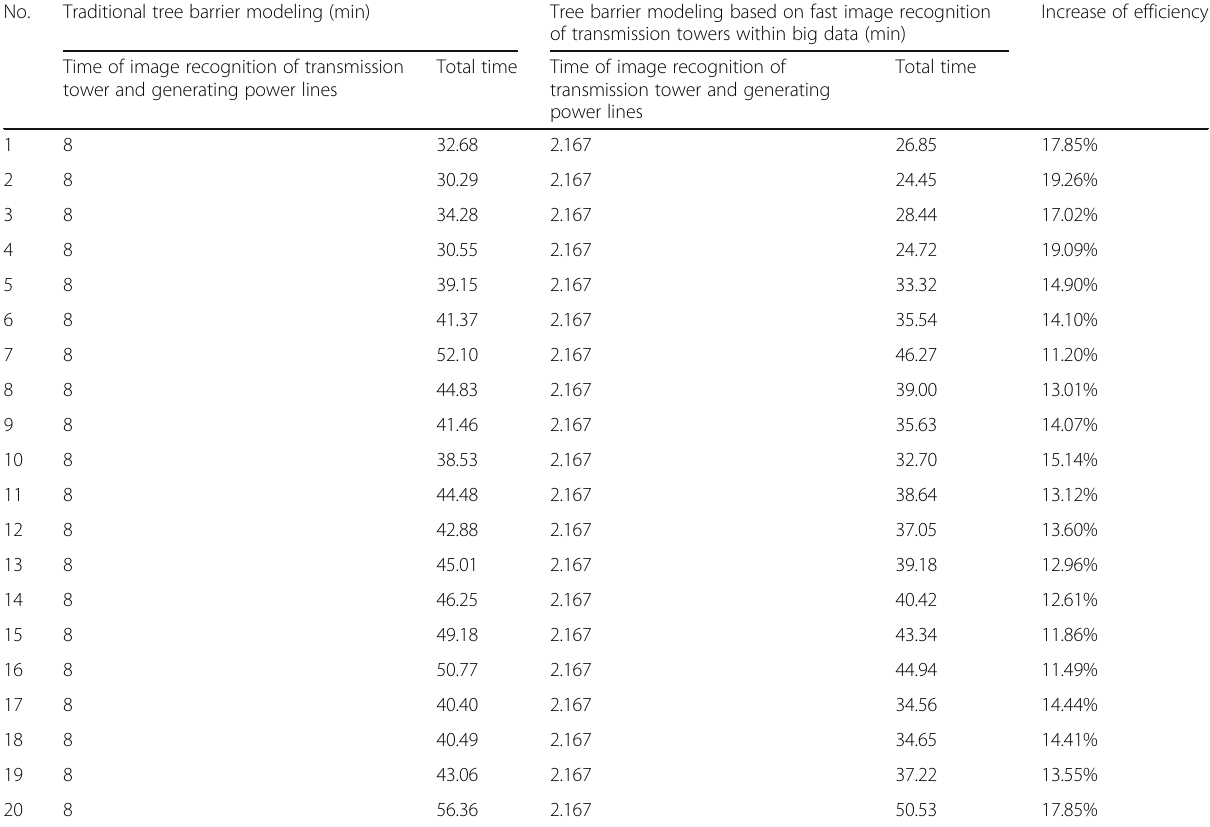
Increase of efficiency